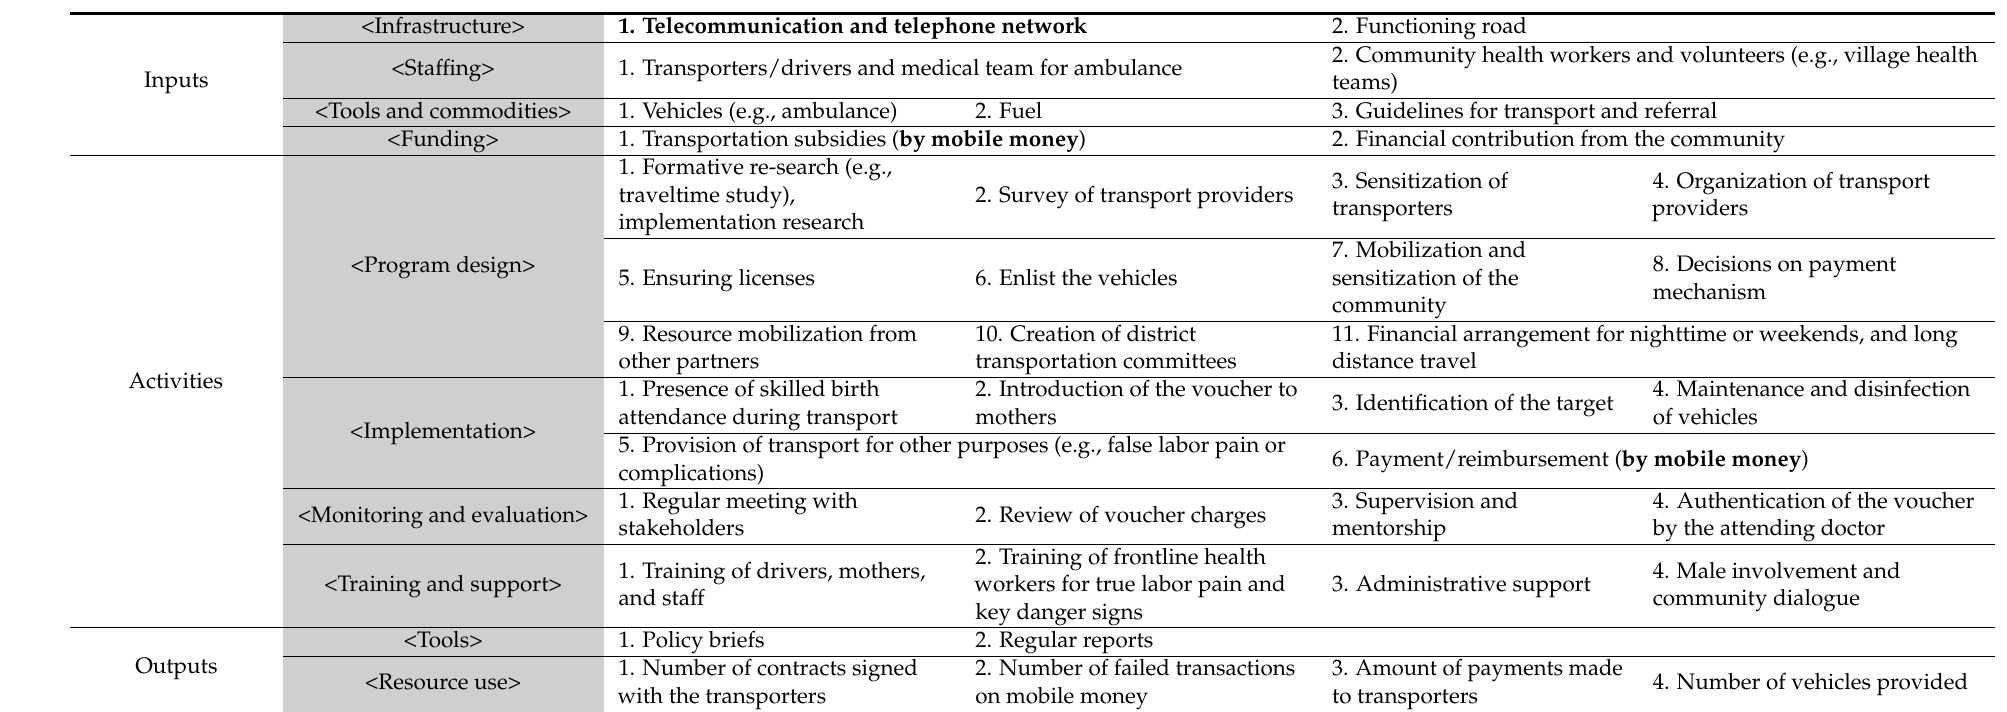
Table 4. Logic model for transportation via maternal health e-voucher